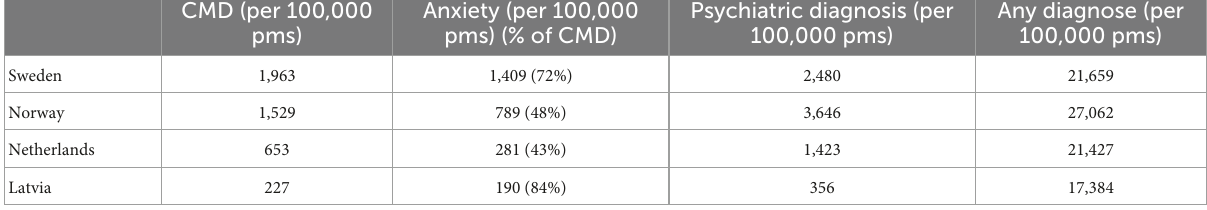
TABLE 1 Baseline prevalence in primary care for common mental disorders, anxiety, any psychiatric conditions, and any diagnosis, respectively.